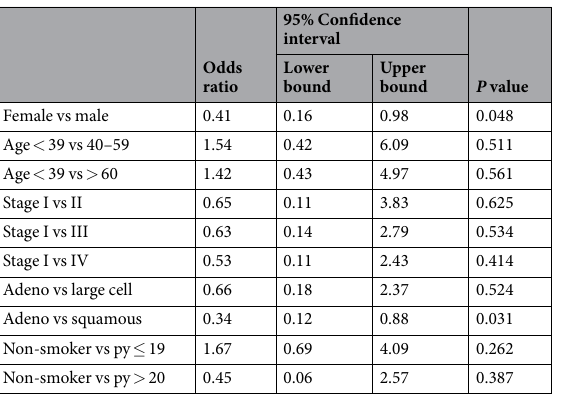
Table 5. Results of binomial logistic regression (BLR) on 48 NSCLC patients, describing the influence of gender, age, cancer stages, tumor types, and smoking status on the state of EGFR